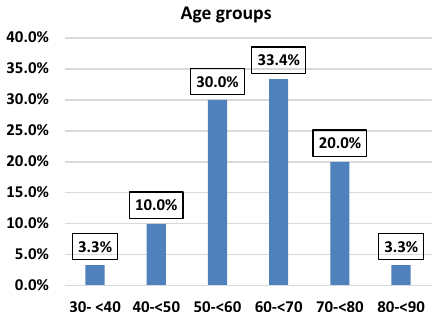
Table 1 Ability of SUVmax for diagnosis of peritoneal carcinomatosis